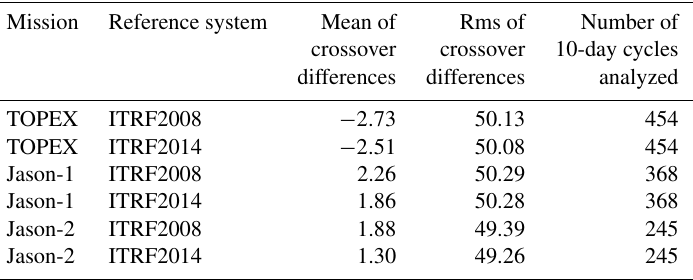
Table 4. Statistics of crossover differences for orbits derived using ITRF2008 and ITRF2014. For Jason-1 the geodetic phase is not considered due to the change in crossover point distribution. The values are means over all 10-day analyses in millimeters. Mission Reference system Mean of Rms